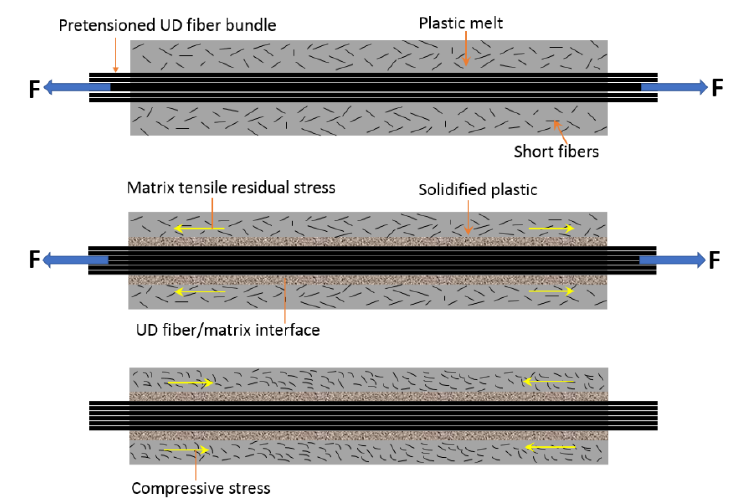
Figure 1. Schematic illustration of the fiber pretension condition.